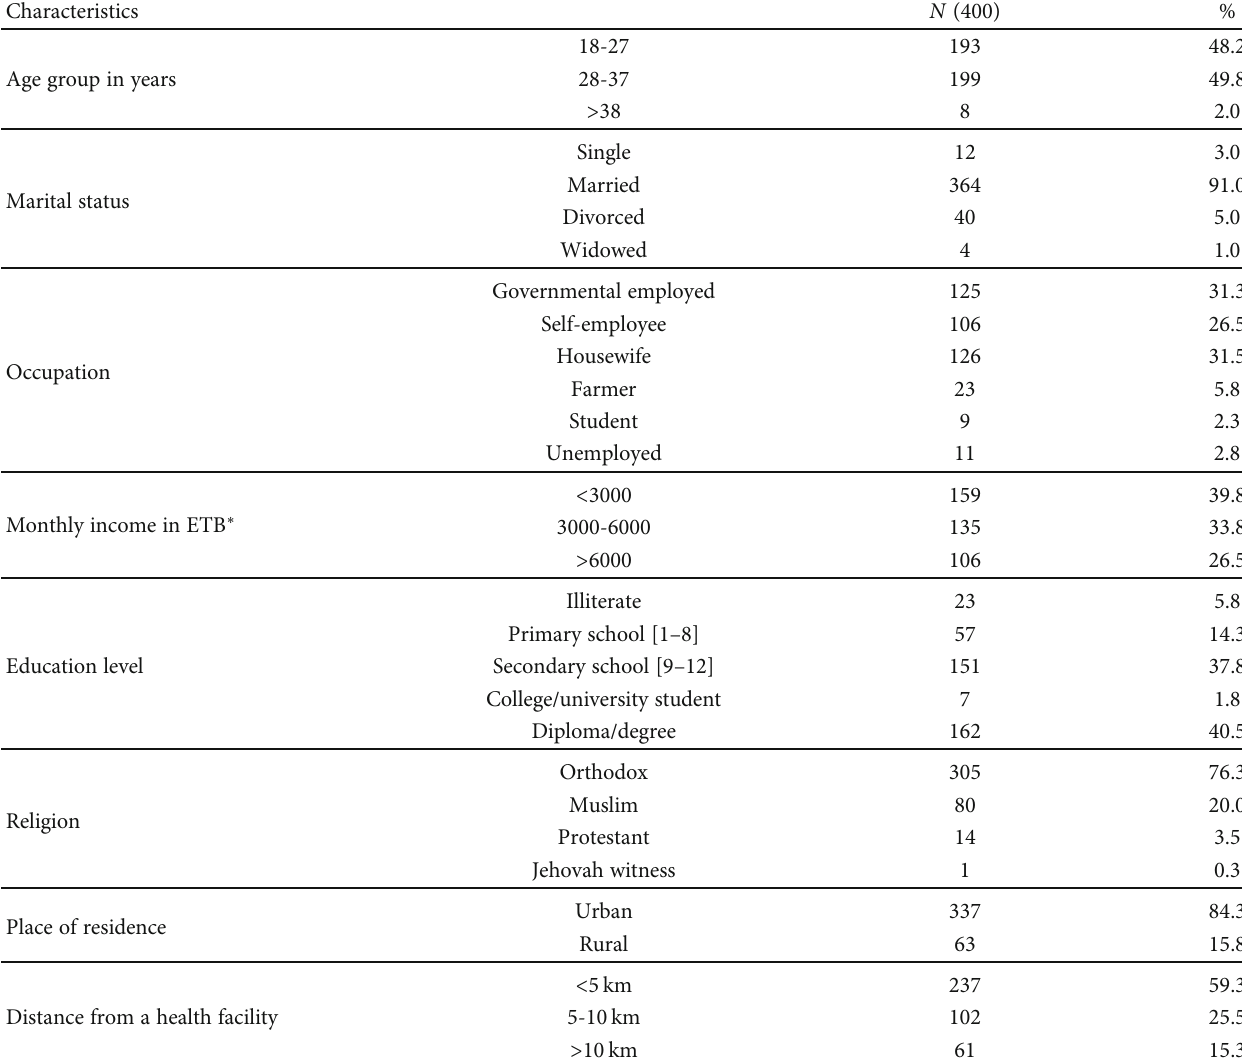
Table 1: Sociodemographic information of the respondents at UoGCSH, June